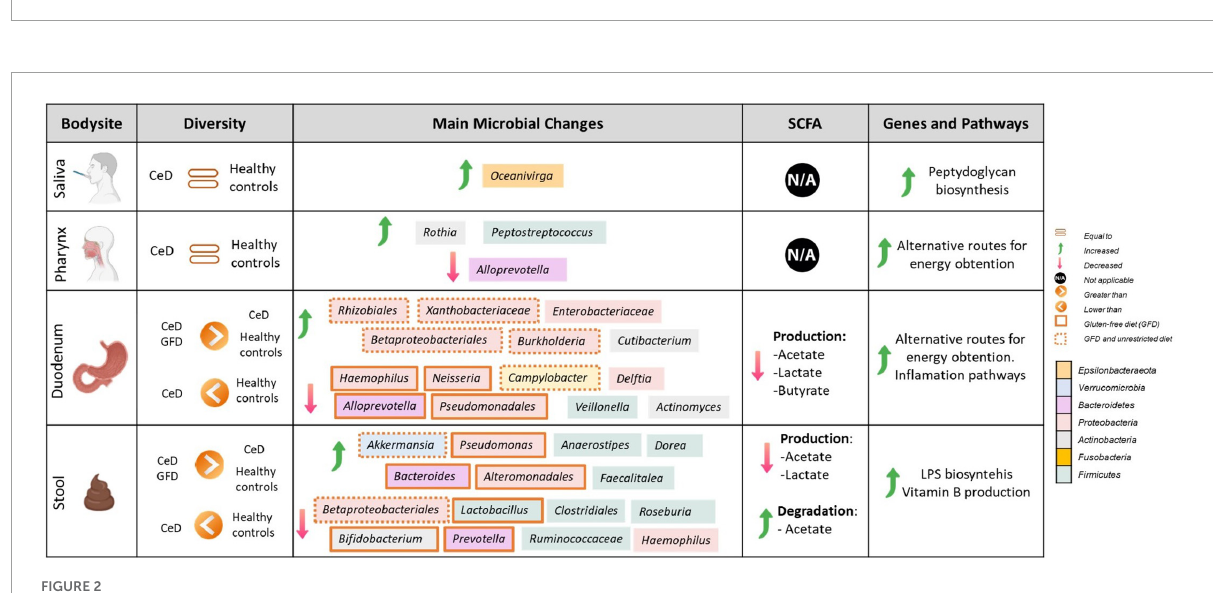
FIGURE2 Comprehensive map of microbial and functional changes observed after data integration. SCFA, short-chain fatty acids; CeD, Celiac disease patients. Figure was created with